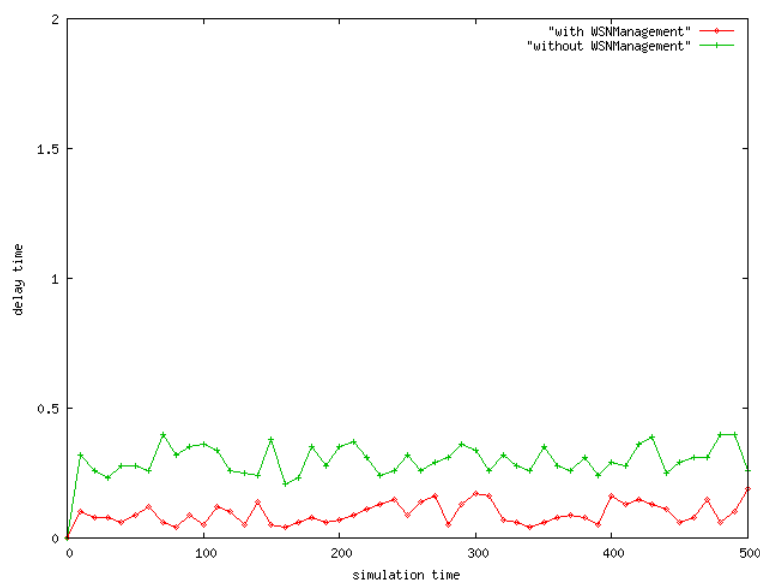
Figure 13. System Delay